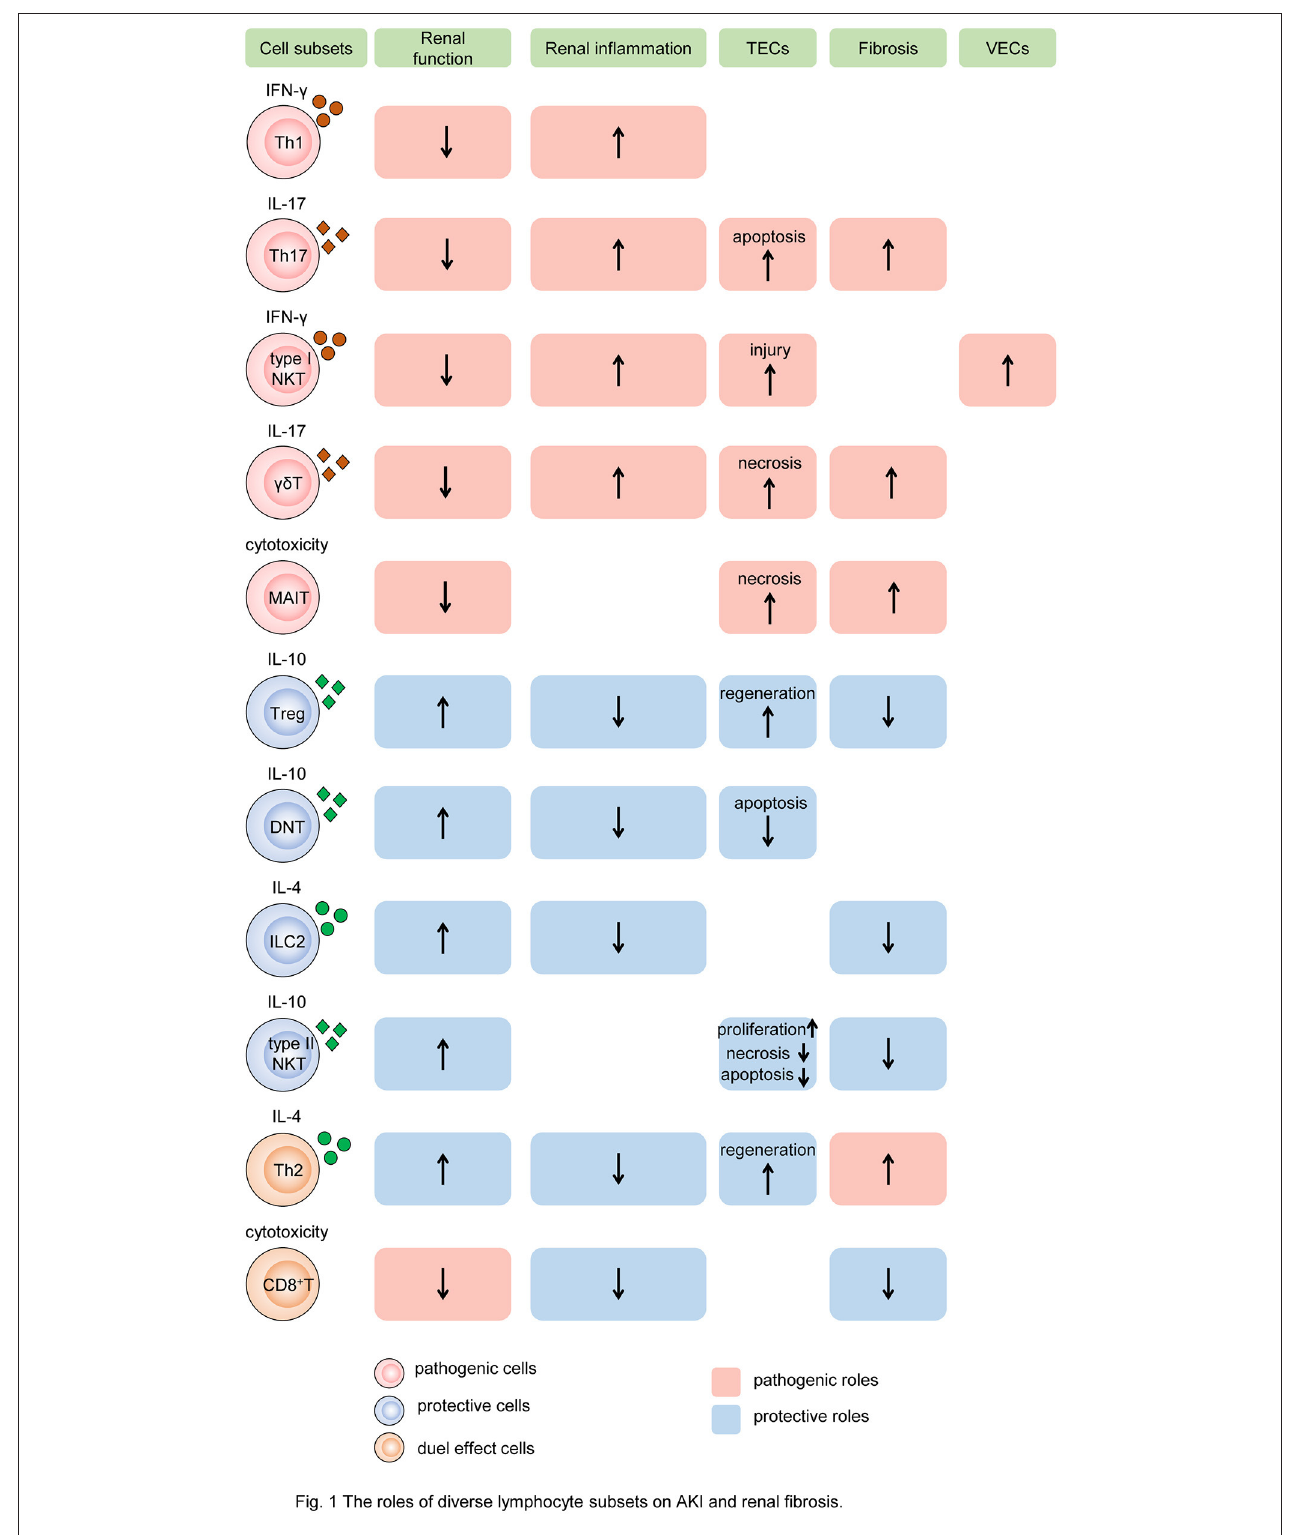
FIGURE 1 | The roles of diverse lymphocyte subsets on AKI and renal fibrosis. Different subsets of T cells, innate-like lymphocytes, and innate lymphoid cells mediate renal injury and fibrosis by regulating intrinsic cell death, proliferation, and fibroblast formation. In the process, cytokine secretion and cytotoxicity are two major mechanisms. Some subsets of lymphocytes, such as Th1, Th17, type I NKT cells, and γδ T cells, produce pathogenic cytokines like IFN- γ , induce renal inflammatory,